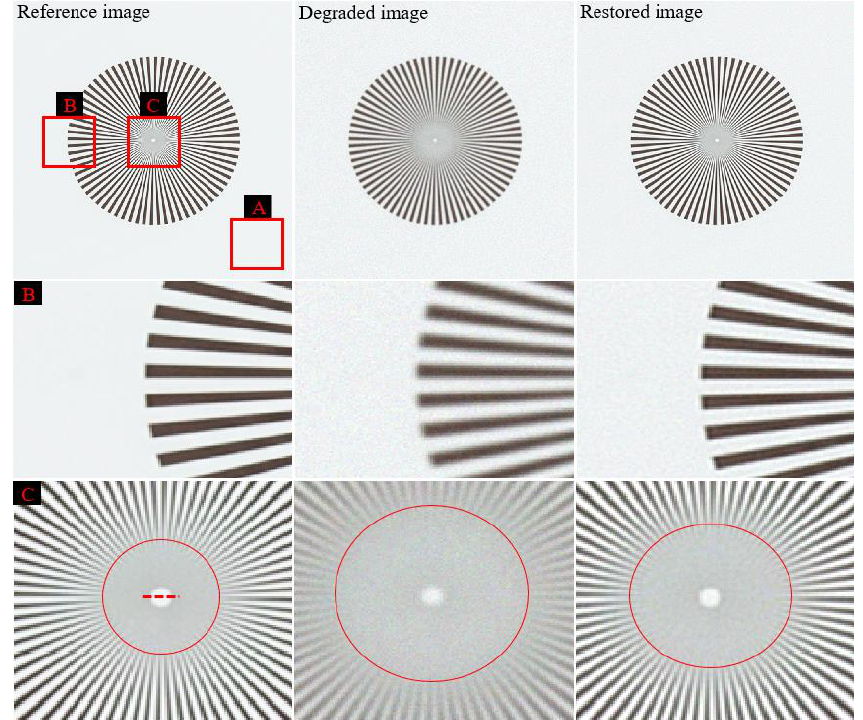
Figure 3. Simulation results including the reference image, degraded image, and image restored using the proposed method. Enlarged images of the regions in boxes B and C are shown.